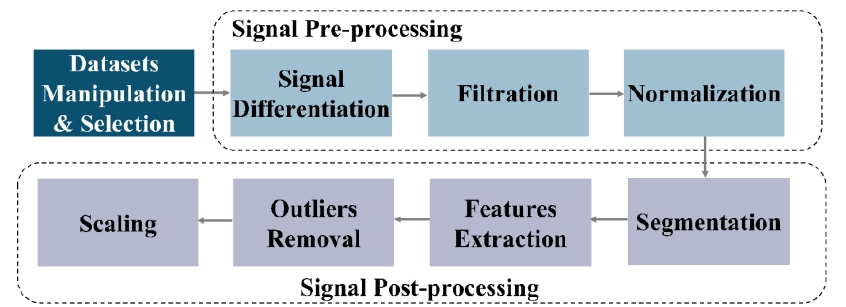
Figure 1. PPG Signal Processing and Feature